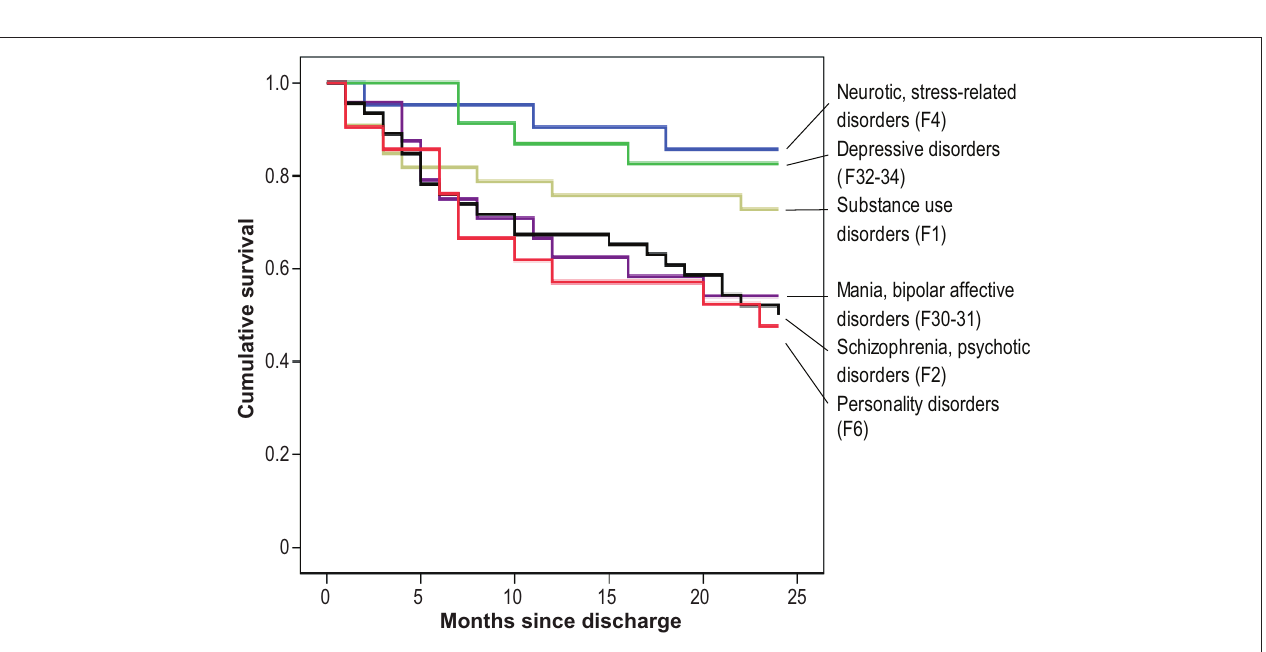
Neurotic, stress-related